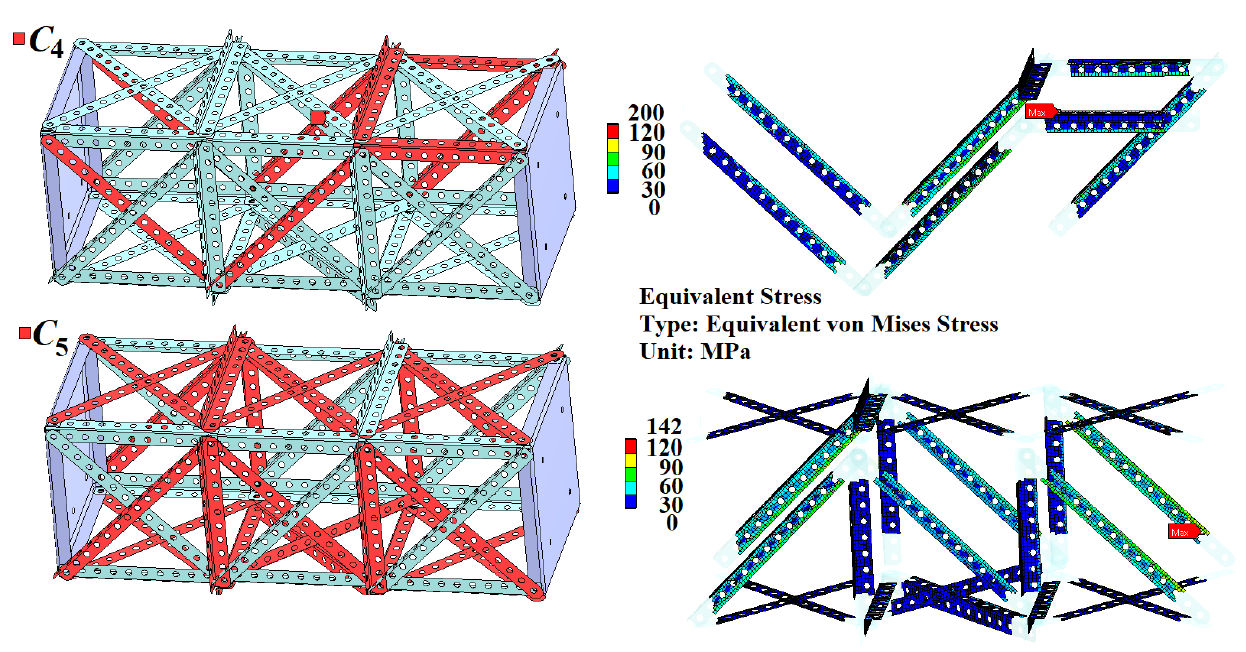
Figure 12. Results for Model 2, with components C 4 and C 5 .